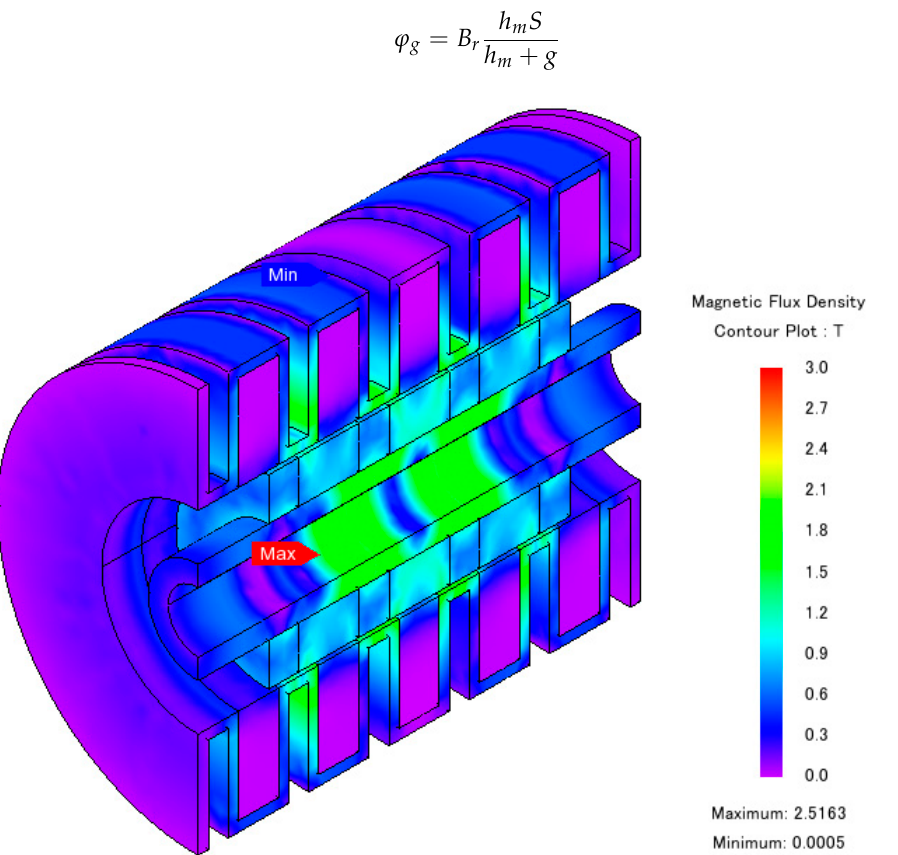
Figure 3. Contour plot of the magnetic flux density across PMLA for the baseline case.